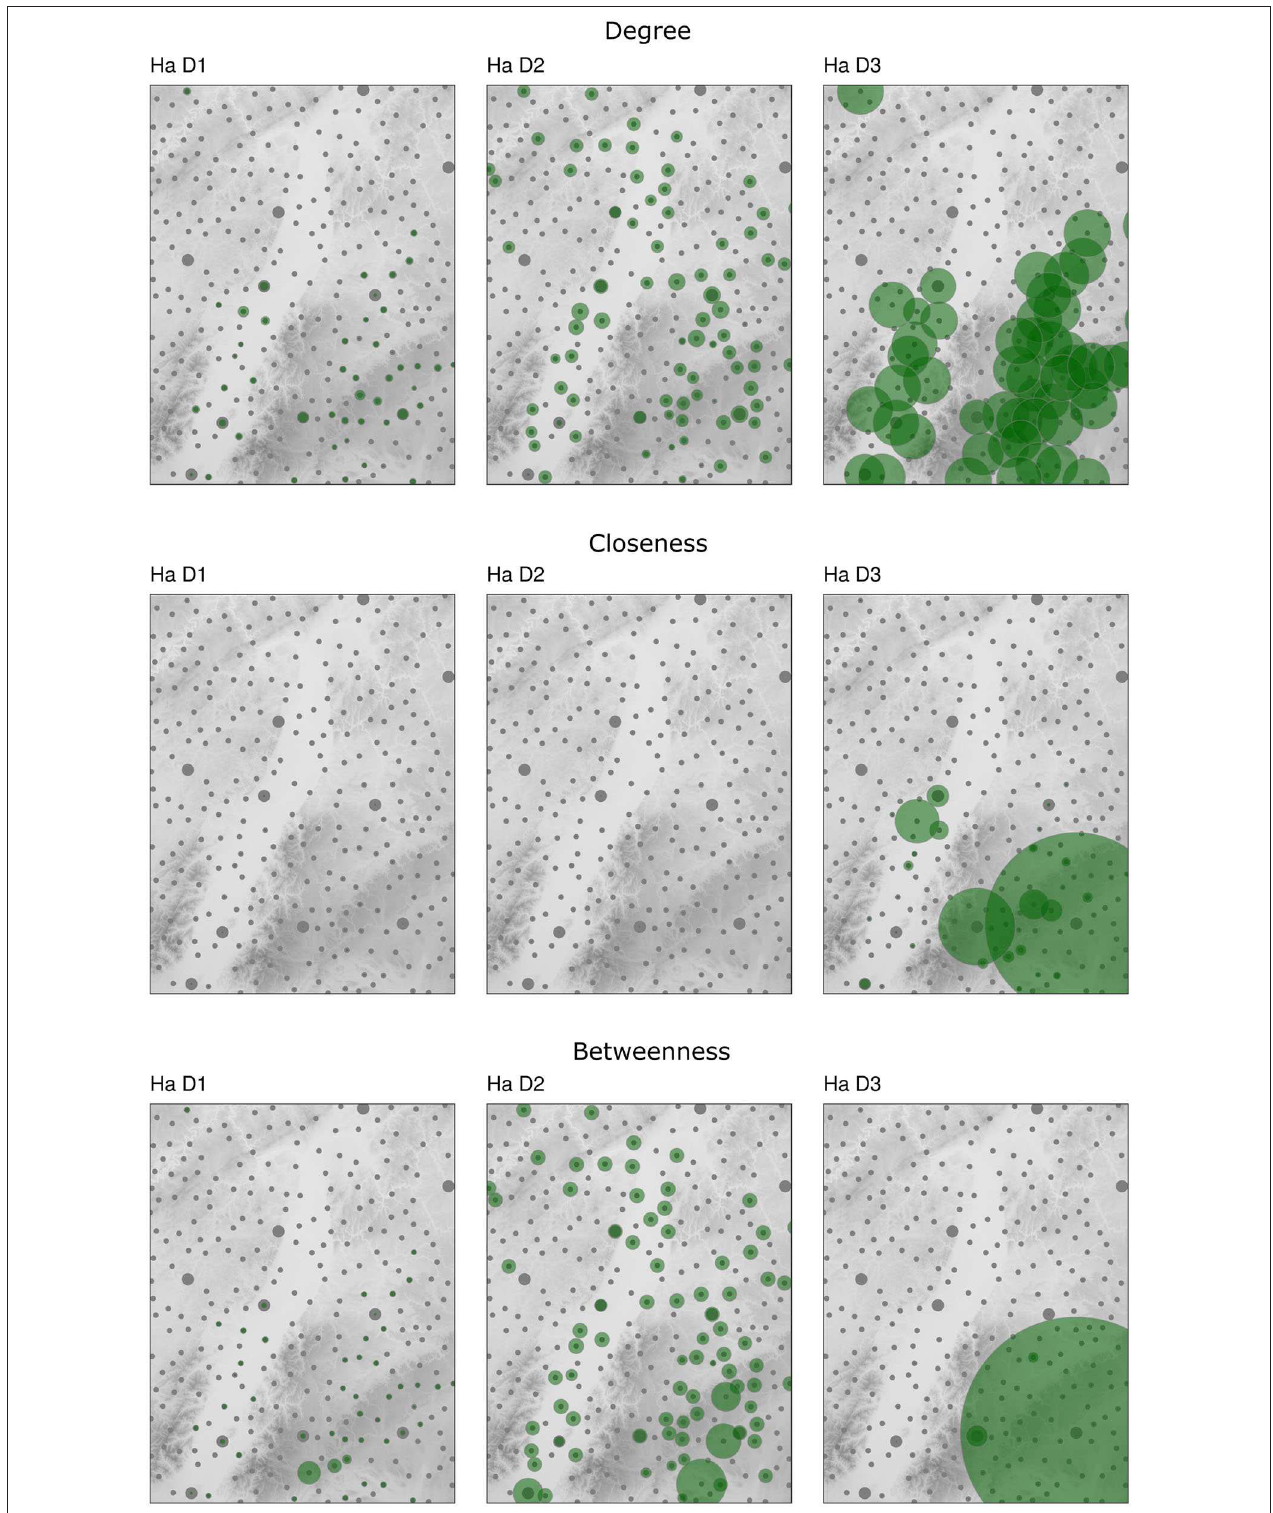
FIGURE 5 | Relative degree, closeness and betweenness of cut graphs. Gray points are the simulated sites and the Princely Seats, the red circles indicate the centrality according to the mentioned index, where the size of the circles corresponds with the centrality. The symbols of each row is scaled differently.